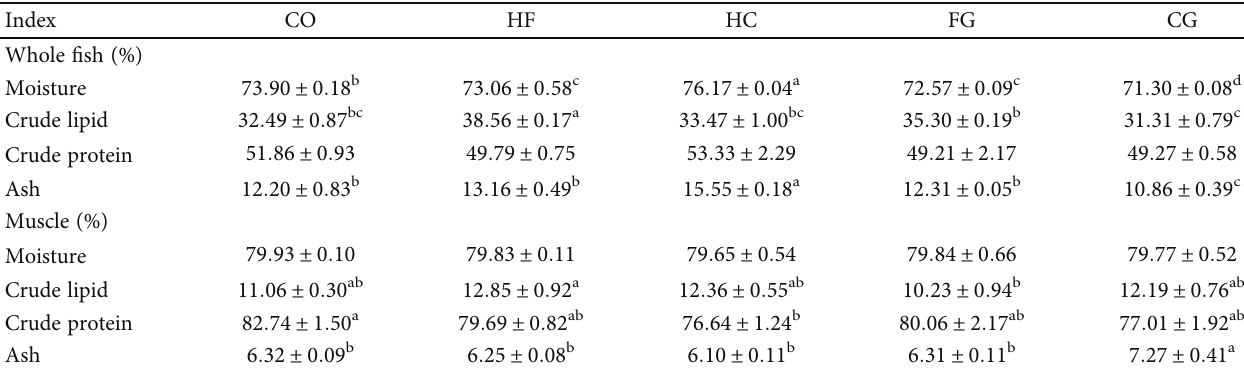
Table 4: The body composition of common carp fed di ff erent experimental diets.